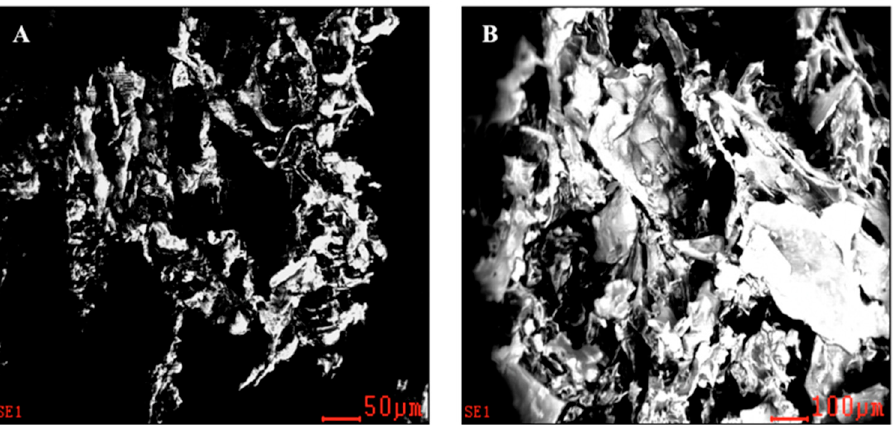
Figure 3. Scanning electron microscopy (SEM) of dry and wet bDLE. ( A ) Topography of the wet bDLE in which a lower density is observed at 50 µ m. ( B ) Topography of dry bDLE, showing a higher density, presumably due to an agglomeration of the components at a scale of 100 μ m. Micrographs taken in a scanning electron microscope (SEM).